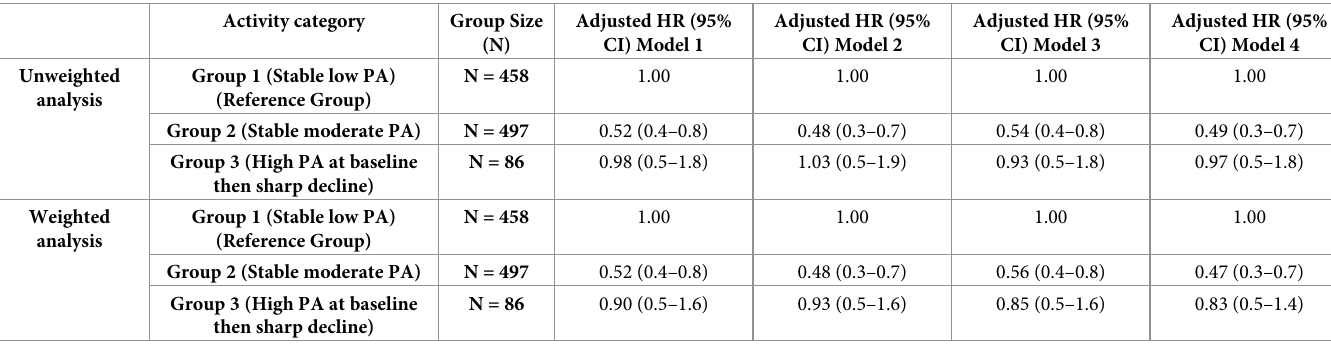
Table 2. Unweighted and weighted estimates of all-cause mortality risk of the groups according to activity category using Cox regression models. Activity